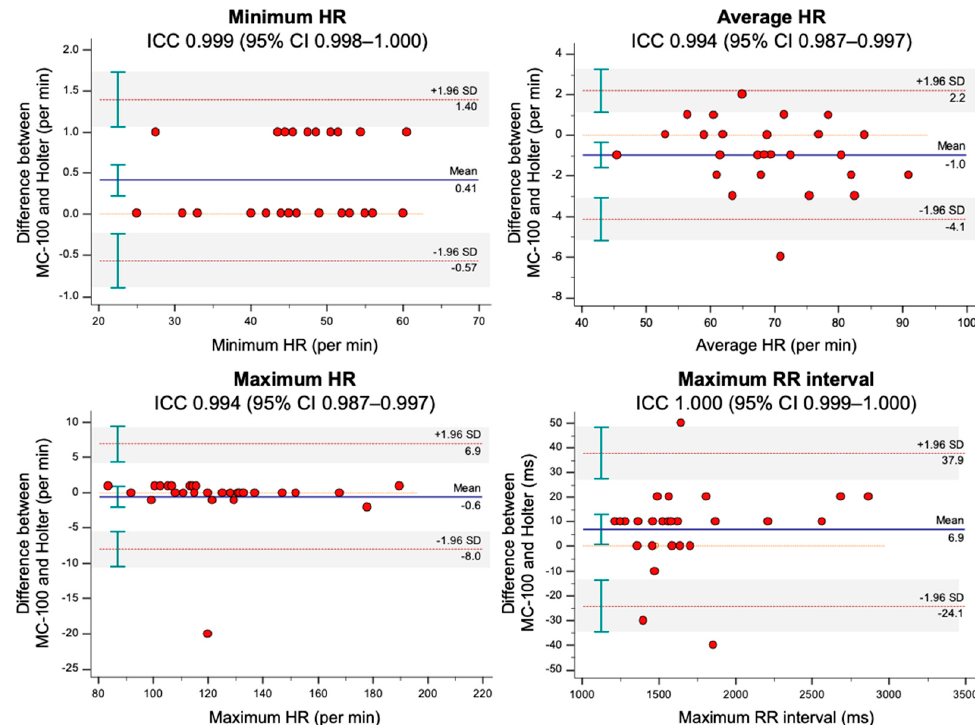
Figure 3. The Bland–Altman plots for ECG parameters, including minimum/average/maximum HR and maximum RR interval. The plots drew with 95% CI of limits of agreement and 95% CI of mean difference. The mobiCARE-MC100 served as a reference. Abbreviations: CI, confidence interval; ECG, electrocardiogram; HR, heart rate; ICC, intraclass correlation coefficient; SD, standard deviation.